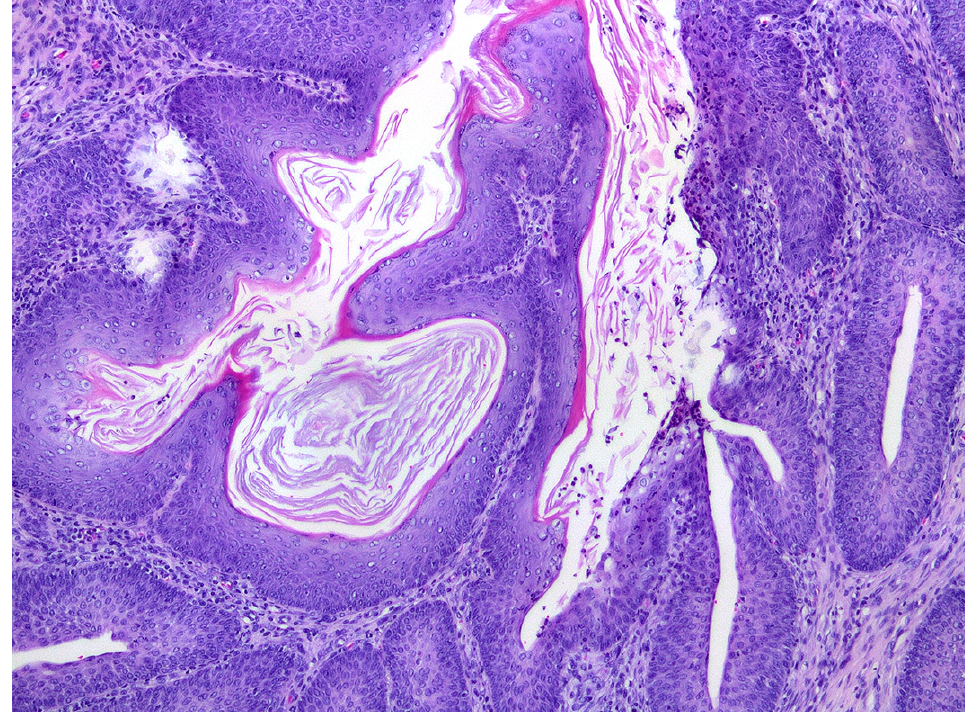
Figure 1. Photomicrograph of the bladder wall of a rat that had a urolith. The uroepithelium is thickened and demonstrates prominent squamous metaplasia. HE 200×.